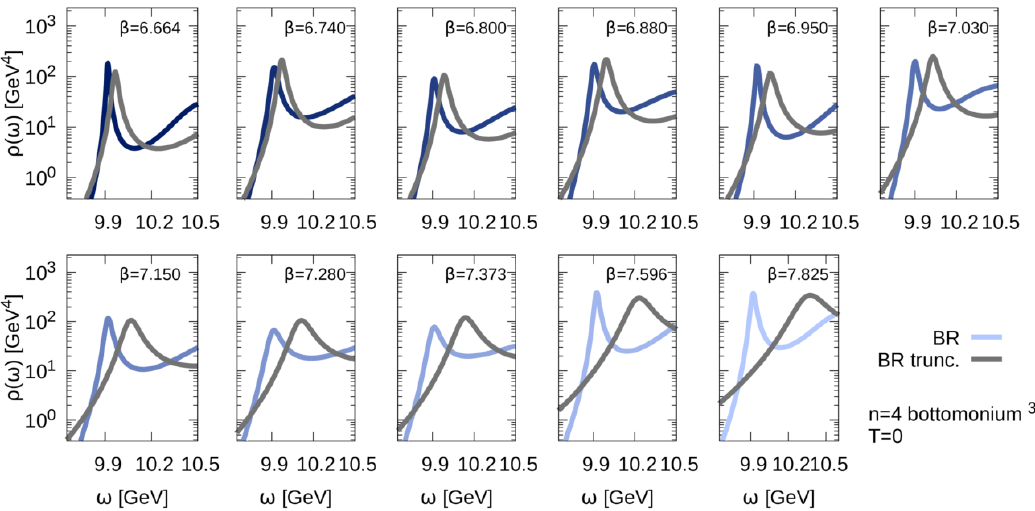
Figure 36 . In(cid:13)uence of truncating the low-temperature simulation data to the same (cid:28) max =a (cid:28) = 12 Euclidean time extent available at (cid:12)nite temperature for bottomonium 3 P 1 channel. The full reconstruction is given by colored solid lines, while the result after truncation is given by the gray solid curves.